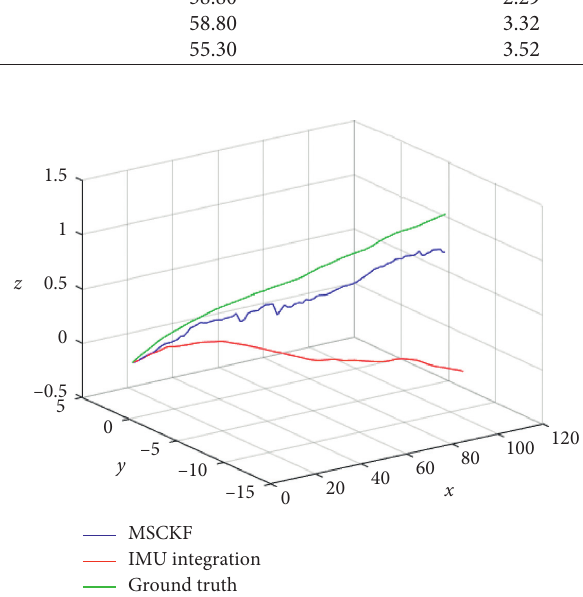
Figure 1: The trajectories by conventional MSCKF algorithm with No. 1 datasets.